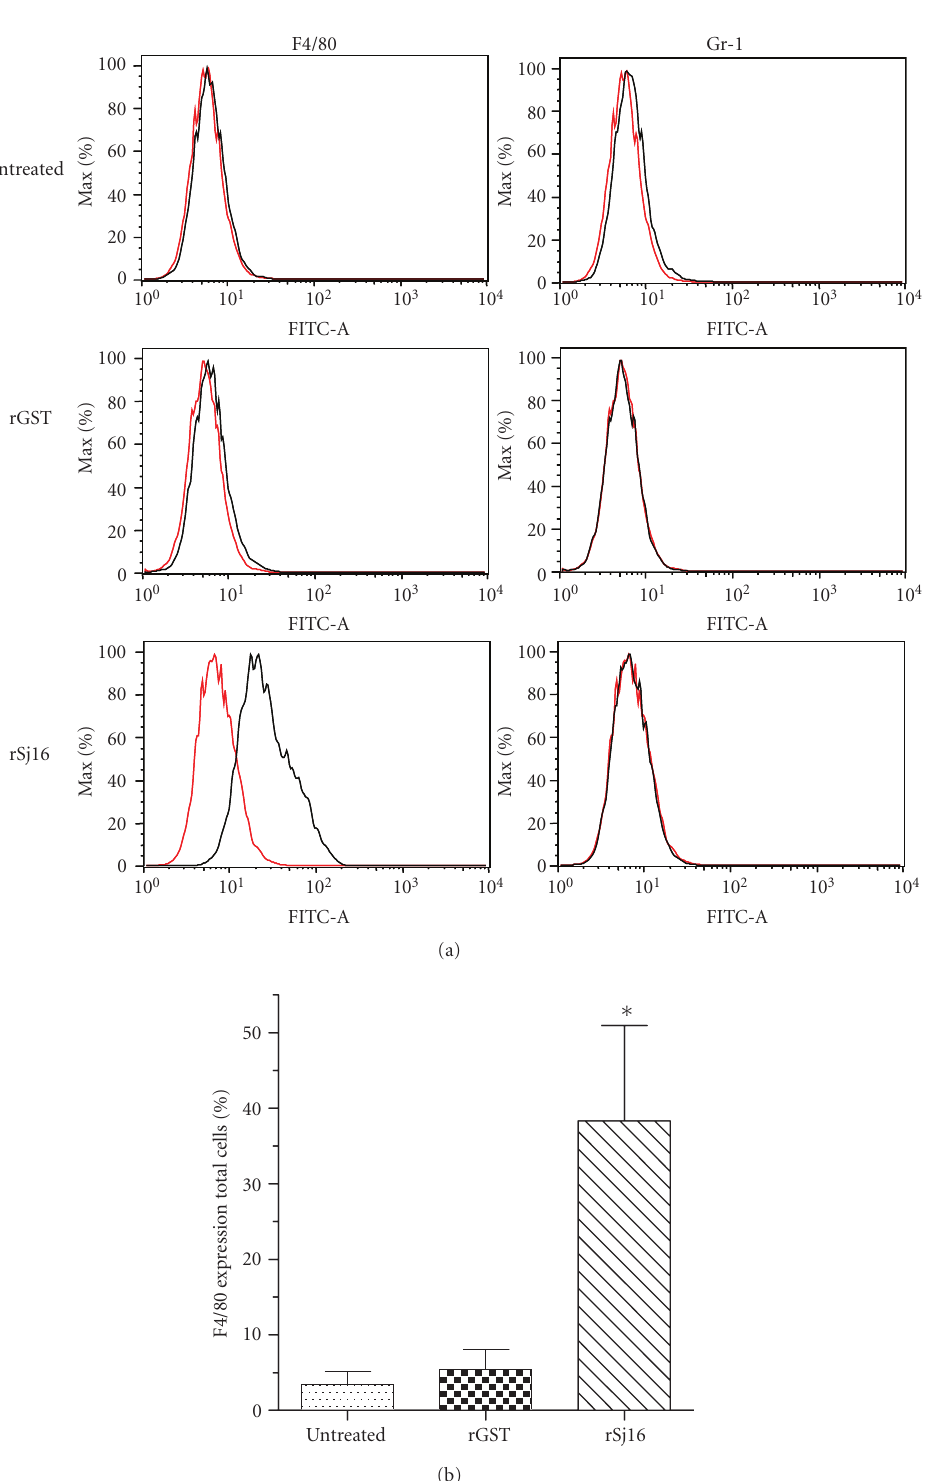
Figure 4: Induction of macrophage marker expression on WEHI-3B JCS cells by rSj16. WEHI-3B JCS cells were treated for 72 hours in the presence of 0.5 μ g/ml rSj16 ( rSj16 ), 0.5 μ g/ml rGST ( rGST ), or medium alone ( untreated ) and then analyzed for expression of F4/80 and Gr-1 using flow cytometry. (a) Red line indicates isotype-matched control antibody; black line, F4/80 or Gr-1. (b) Column indicates mean ± SEM of four independent experiments. ∗ P < . 05 as compared with that of untreated